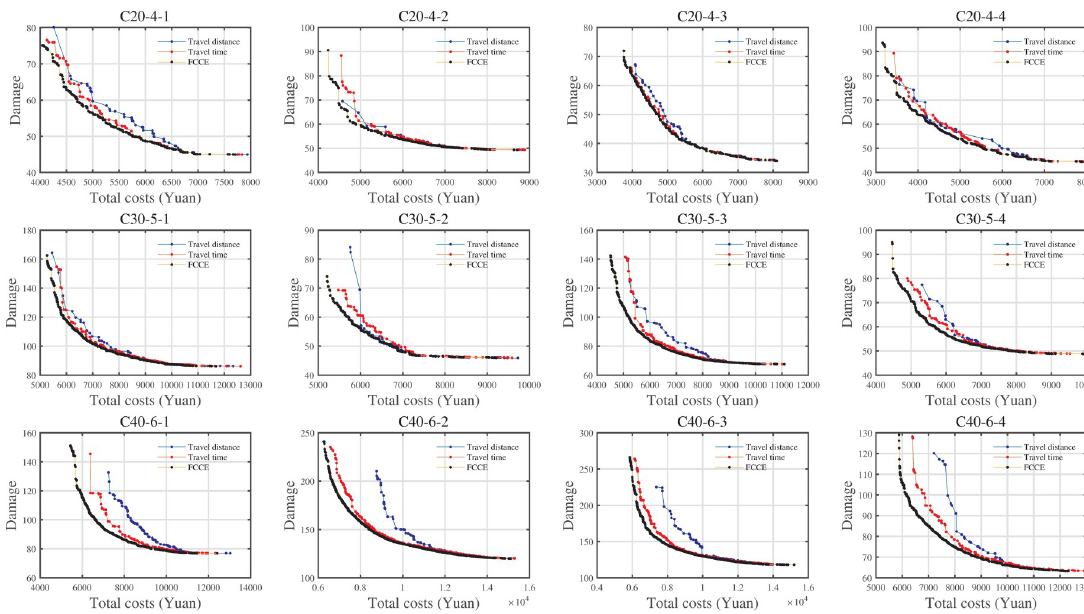
Fig 6. Pareto fronts obtained by three